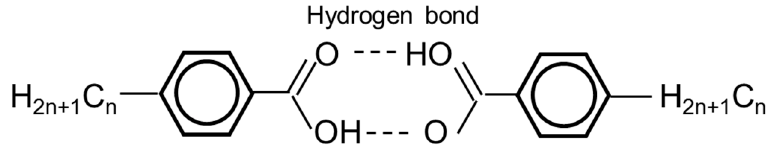
Figure 1. Molecular structure of hydrogen-bonded liquid crystal.